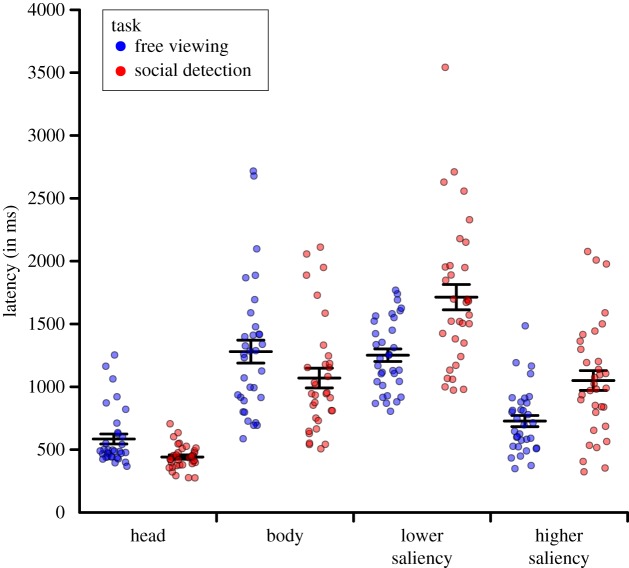
Latency. Median latency after stimulus onset (in milliseconds) until each region of interest (ROI) was fixated for the first time, separately for the two task conditions (free viewing versus spotting people as fast as possible). Each point represents one participant. Points were jittered to reduce overlap. The long black horizontal bars indicate the corresponding mean values, the surrounding black error bars denote s.e.m.